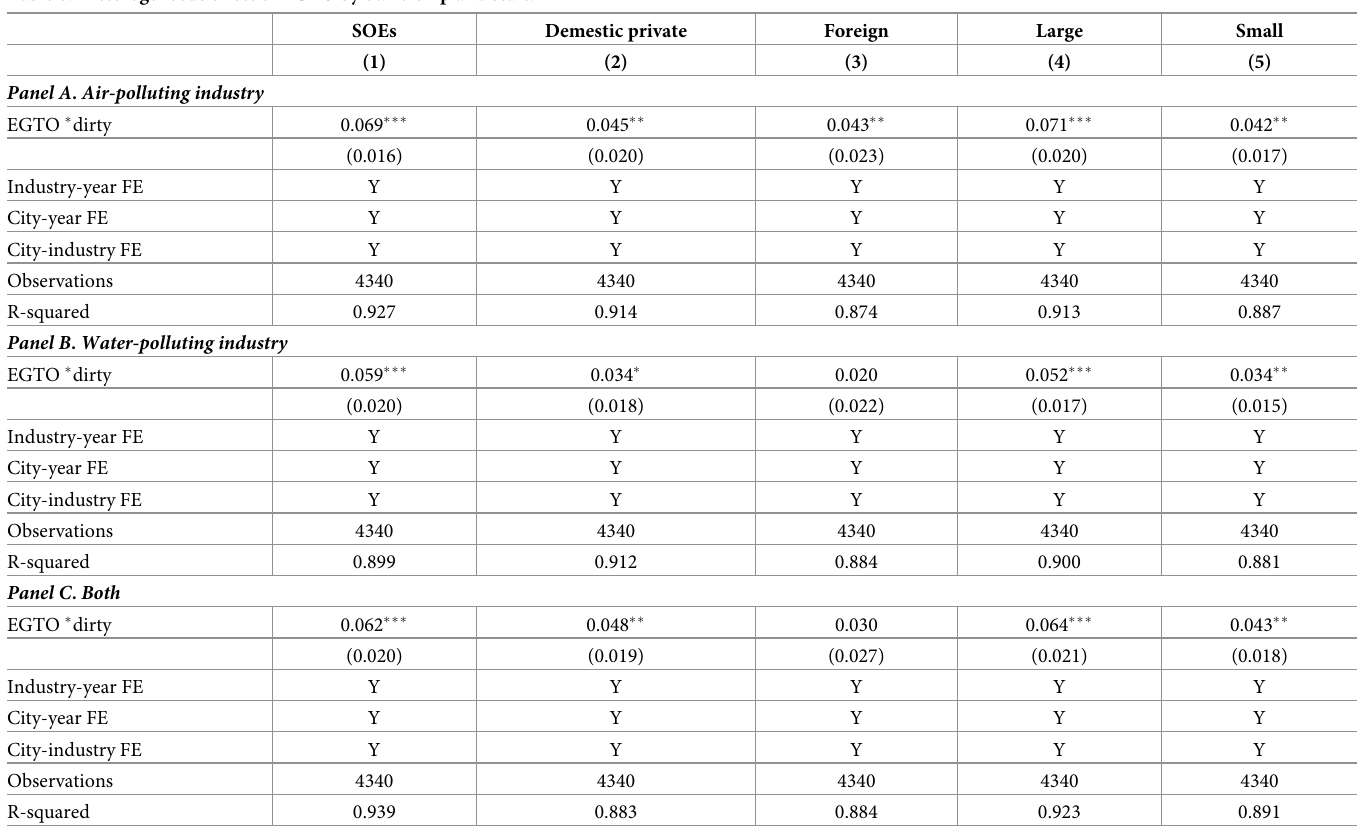
Table 6. Heterogeneous effect of EGTO by ownership and